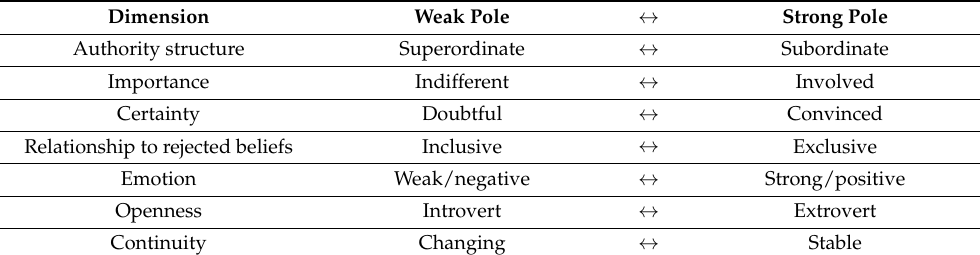
Table 1. The seven Dimensions and their associated Poles. Dimension Weak Pole ↔ Strong